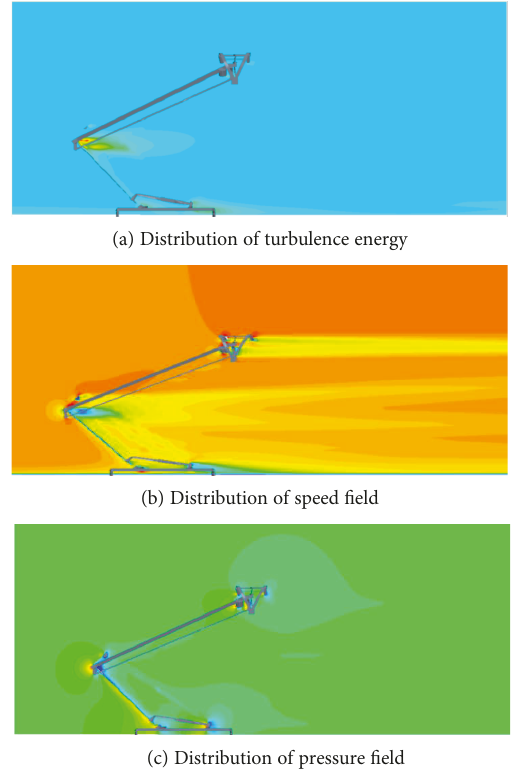
Figure 14: Distribution of fl ow fi elds of improved pantograph.